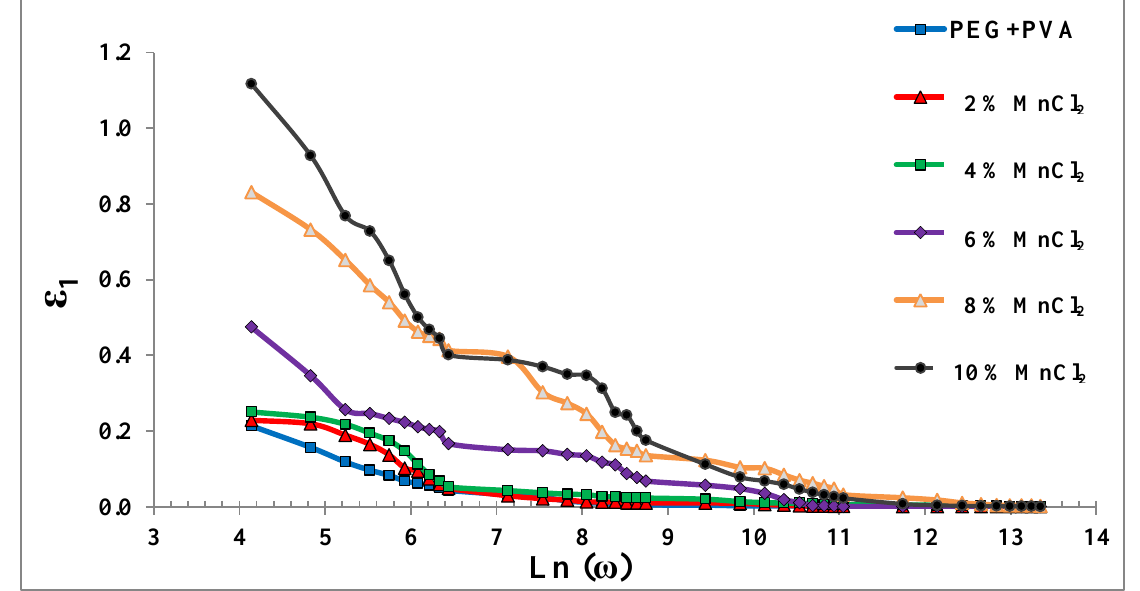
Fig. 3B: The variation of the dielectric constant of (PVA:PEG- (MnCl